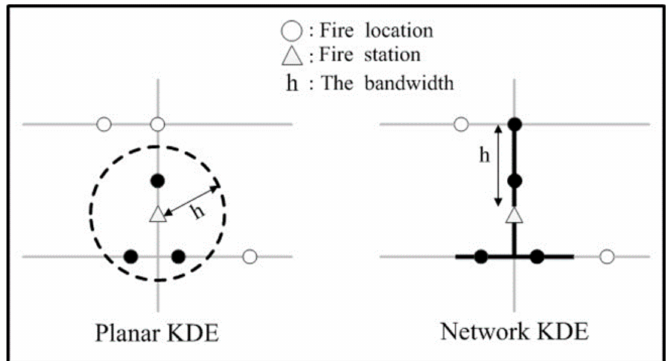
Figure 7. Illustration of the differences between the planar KDE and network KDE for the same point event